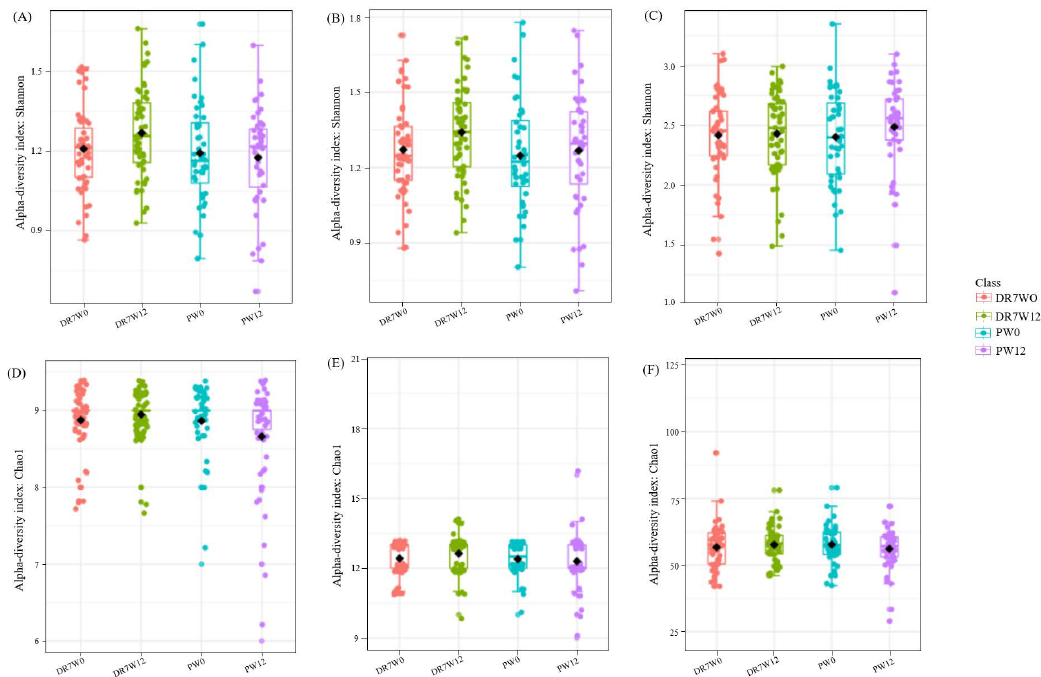
Figure 3. Alpha diversity plots for stressed adults at baseline (W0) and after week-12 (W12), upon administration of Lactobacillus plantarum DR7 or placebo. Diversity measured by Shannon Evenness Index for ( A ) class (W0: p = 0.264; W12: p = 0.034), ( B ) order (W0: p = 0.316; W12: p = 0.116), and ( C ) genus (W0: p = 0.919; W12: p = 0.351), and Chao1 Richness Index for ( D ) class (W0: p = 0.876; W12: